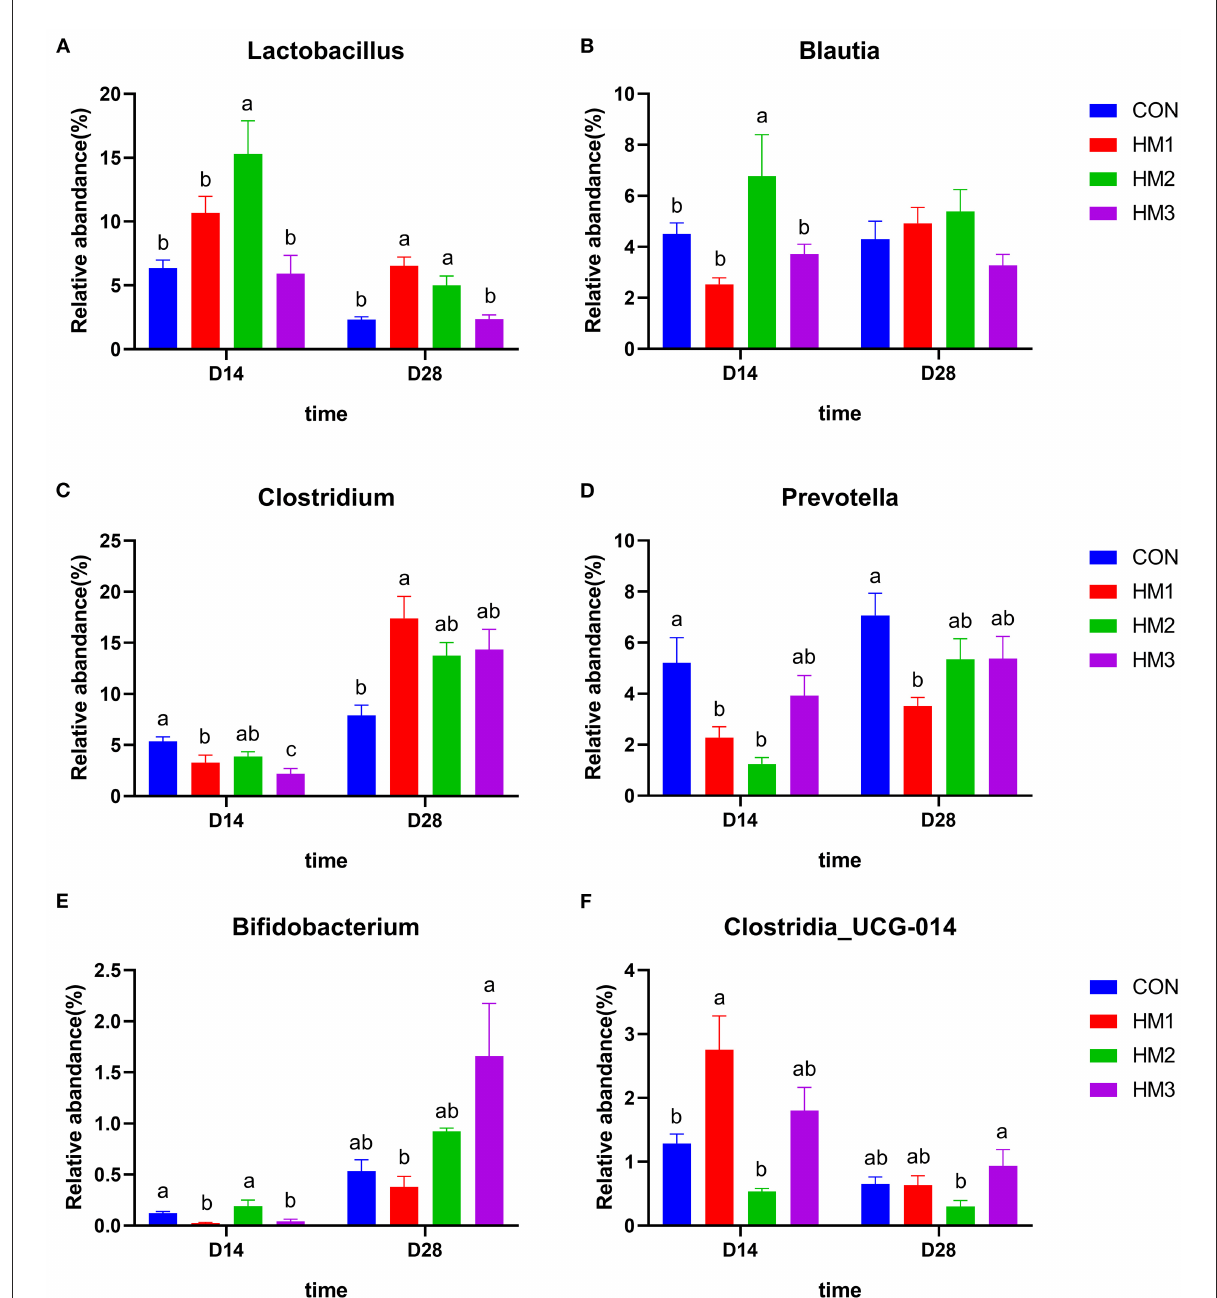
FIGURE4 Comparison of dominant intestinal microbiota at genus level. Relative abundances of Lactobacillus (A) , Clostridium (B) , Blautia (C) , Clostridia_UCG-014 (D) , Prevotella (E) , and Bifidobacterium (F) among the four groups on d 18 and d 35. CON, basic diet; HM1, basic diet with 0.5 g/kg of herbal mixture; HM2, basic diet with 1.0 g/kg of herbal mixture; HM3, basic diet with 1.5 g/kg of herbal mixture. Different lowercase letters in the figure indicate statistically significant differences ( p < 0.05).